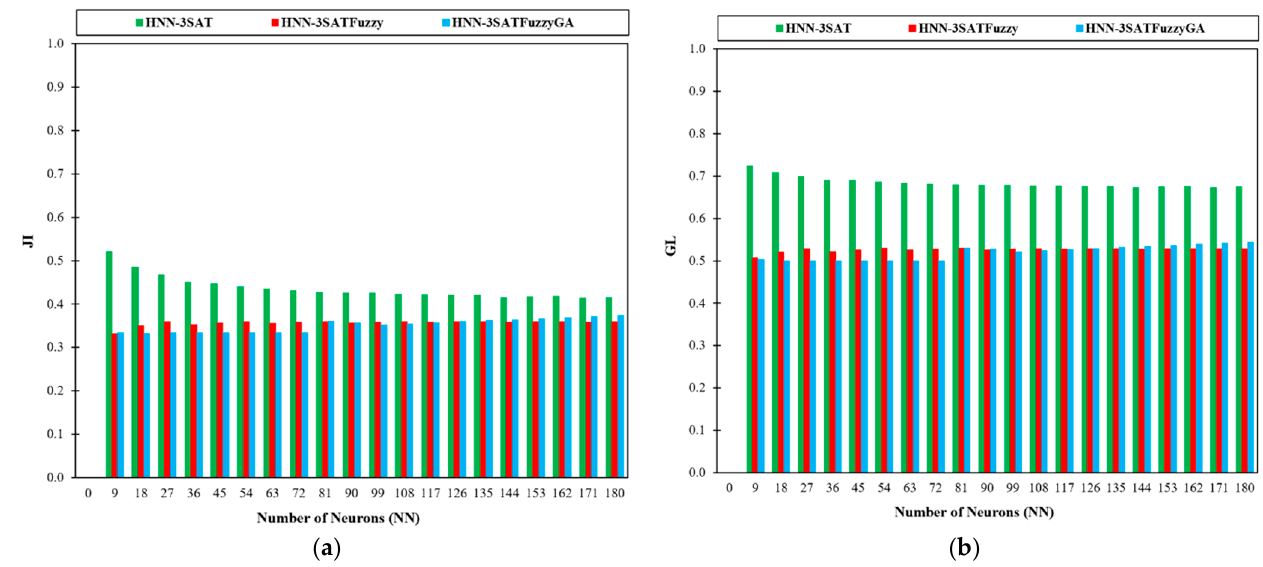
Figure 6. The similarity metrics ( a ) Jaccard Index; ( b ) Gower and Legendre Index. Next, we used the similarity index to analyse the similarity and dissimilarity of the generated final neuron states in Figure 6a,b. This indexing is used for divergence investi- gations. It is particular to binary variables [33]. According to Equations (25) and (26), we searched for the Jaccard Index (JI) and the Gower-Legendre Index (GLI) in the similarity index analysis. A comparison of the JI and GLI values obtained by several HNN-3SAT